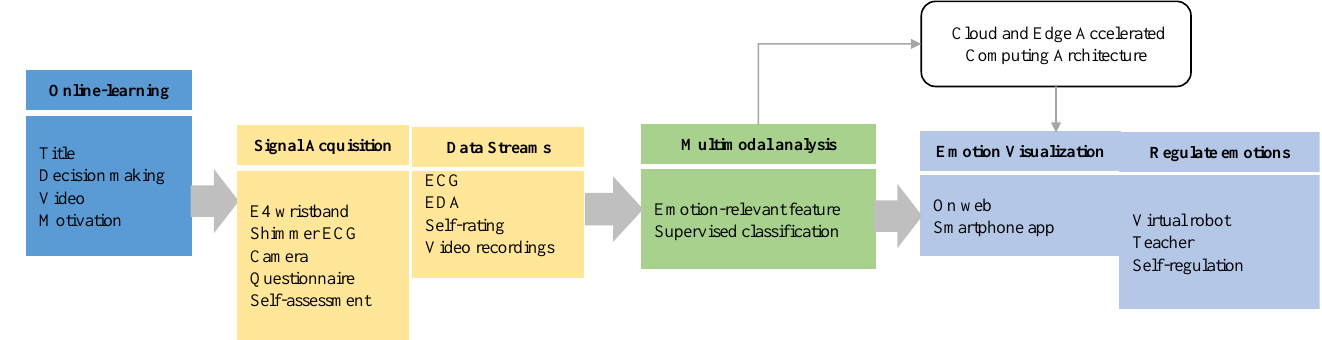
Figure 6. Experimental flow chart.